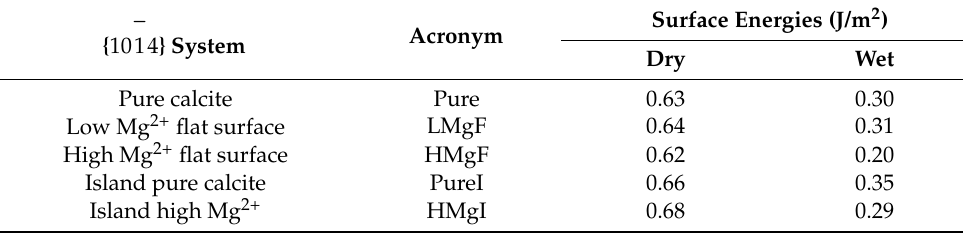
Table 2. Overview of the surface energies of the simulated systems.